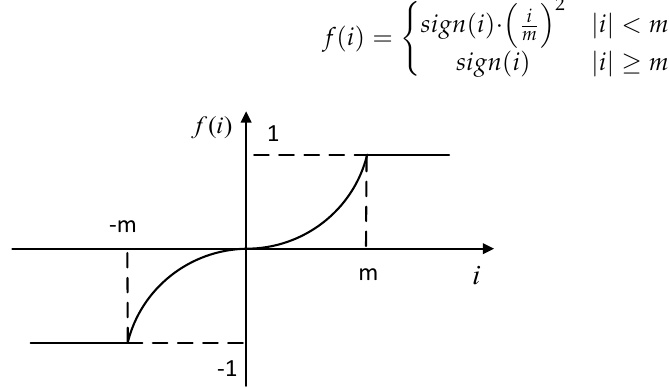
Figure 7. Improved linear compensation function.